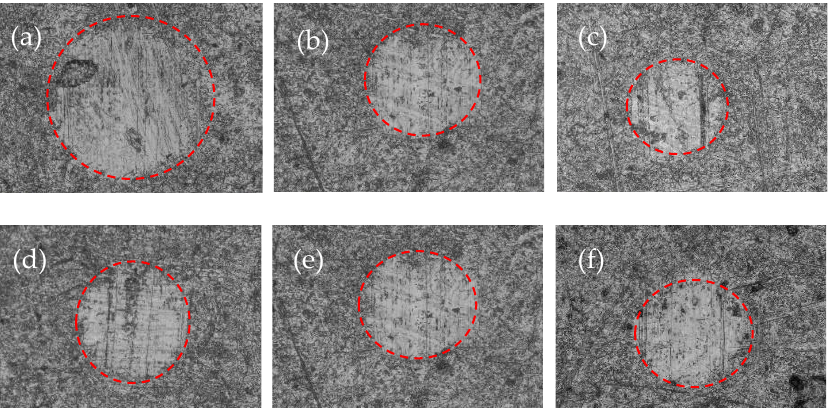
Figure 6. Wear scar micrographs of the lubricated plates with oleo-dispersions formulated with 70:30 LSL:EC nanostructures at different concentrations ( a ) 10 wt.%, ( b ) 20 wt.%, and ( c ) 30 wt.% and different LSL:EC ratios ( d ) 50:50, ( e ) 70:30, and ( f ) 90:10 and 20 wt.% nanostructure concentrations. Table 3. Average values of the friction coefficient and wear scar diameters obtained with the disper- sions of LSL:EC nanostructures in castor oil acting as lubricants. Concentration Ratio LSL:EC (wt%)